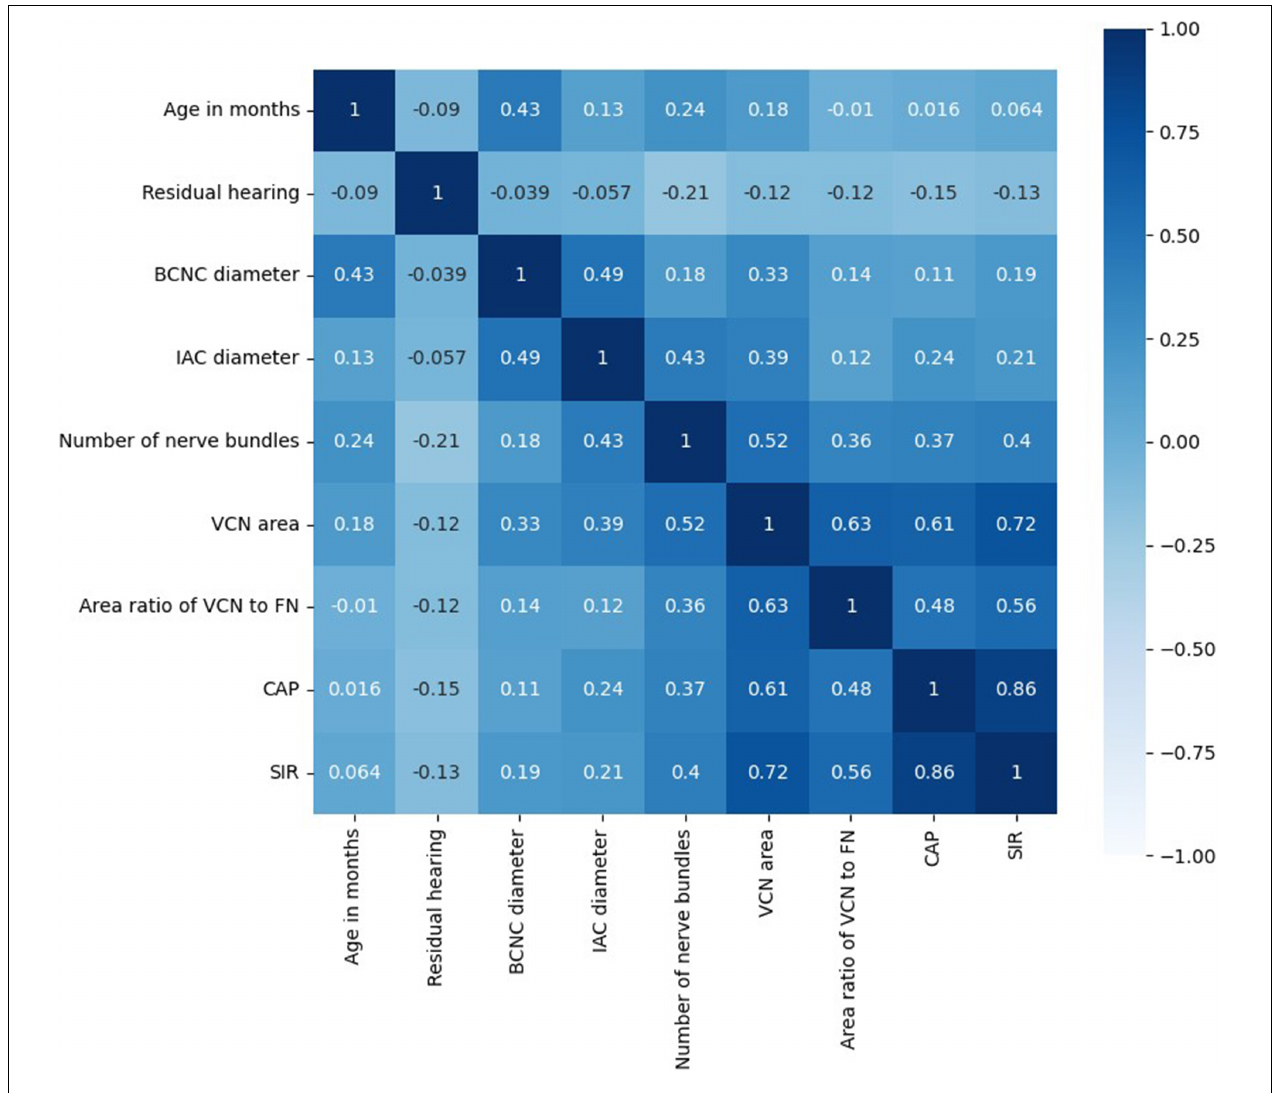
FIGURE 7 | Correlation coefficient